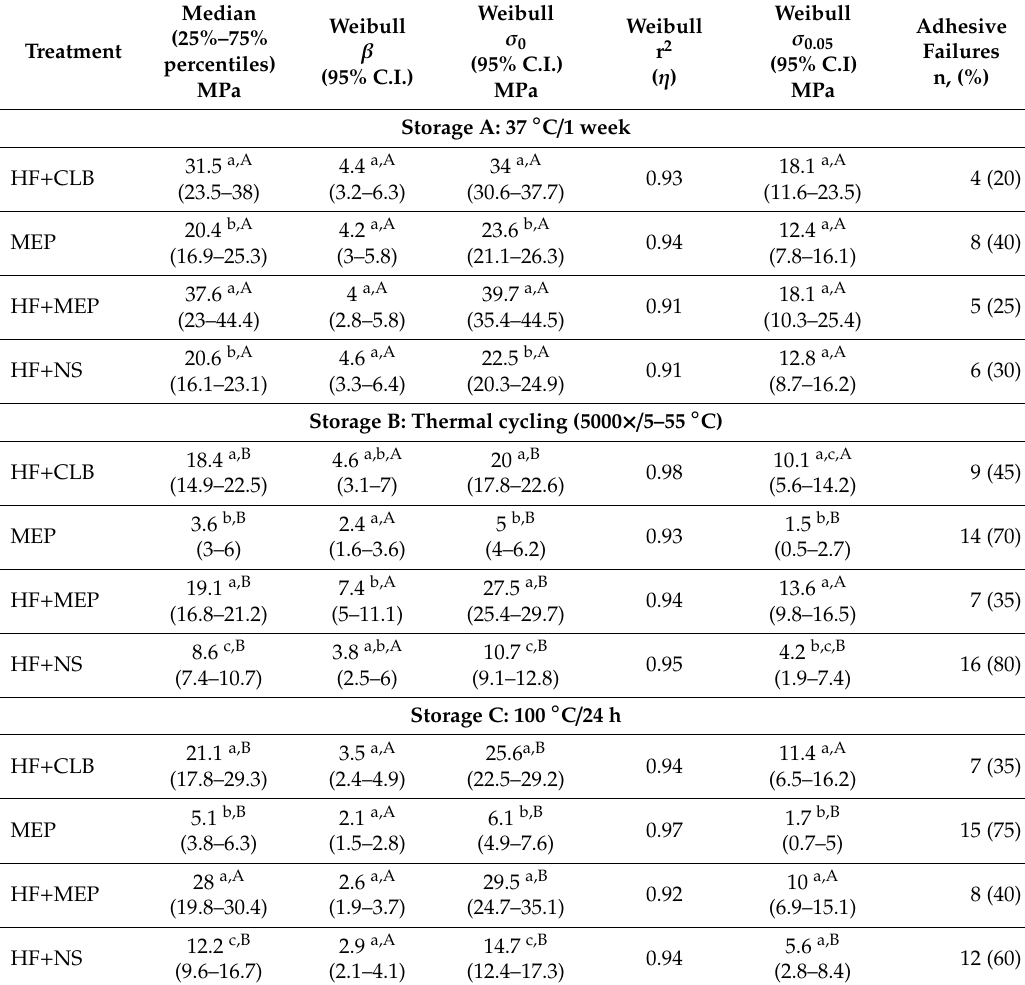
Table 3. Results of the shear bond strength test and percentage of adhesive failures